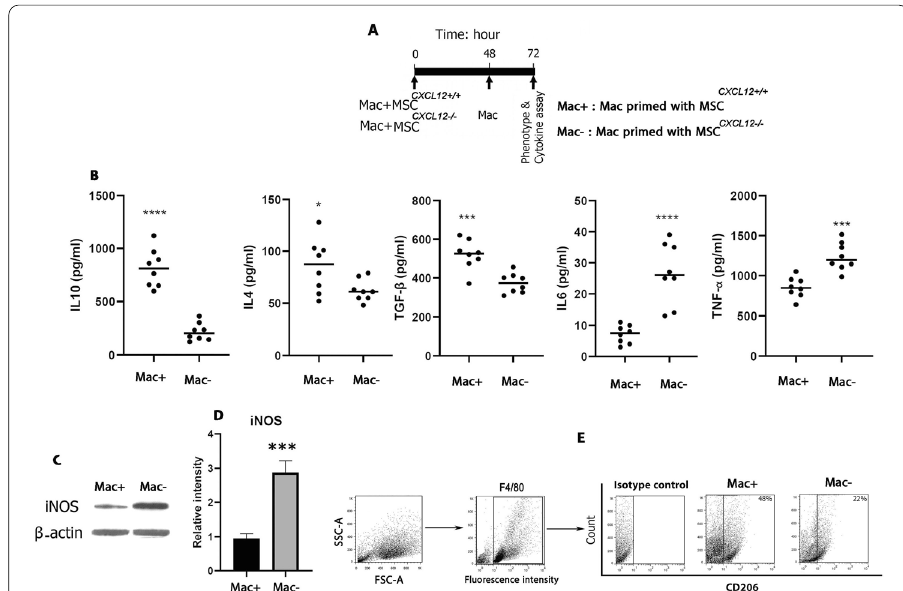
Fig. 2 Macrophage phenotypic switching by MSC‑derived CXCL12 niche. Schematic diagram of macrophage and MSC cocultures. Bone marrow macrophages were cocultured with MSCs in non‑contact Transwell inserts for 48 h. Then, macrophages were incubated for a further 24 h before submission for phenotype and cytokine assays ( A ). Cytokine levels of IL10, IL4, TGF‑β, IL6 and TNF‑α in supernatants of macrophages after non‑contact coculture with MSCs CXCL12+/+ (M2) or MSCs CXCL12 − / − (M1). Each point indicates an experiment (horizontal lines: mean) ( B ). Western blot depicting protein levels of iNOS ( C ). Left and right lanes indicate iNOS in Mac in the presence of MSCs CXCL12+/+ and MSCs CXCL12 − / − , respectively. Representative data from three independent experiments ( C ). Quantitative analysis of iNOS levels ( D ). Representative flow cytometry dot plots of CD206 expression by macrophages after culturing with MSCs CXCL12+/+ (M2) or MSCs CXCL12 − / − (M1). MSC‑derived CXCL12 niche strongly induced CD206 expression by macrophages ( E ). Representative FSC/SSC and F4/80 gating is shown. Data from three independent experiments with the mean percentage of positive cells in each group are shown within histograms ( E ). * P < 0.5, *** P < 0.001, **** P < 0.0001, Student’s t‑test. Mac, macrophage